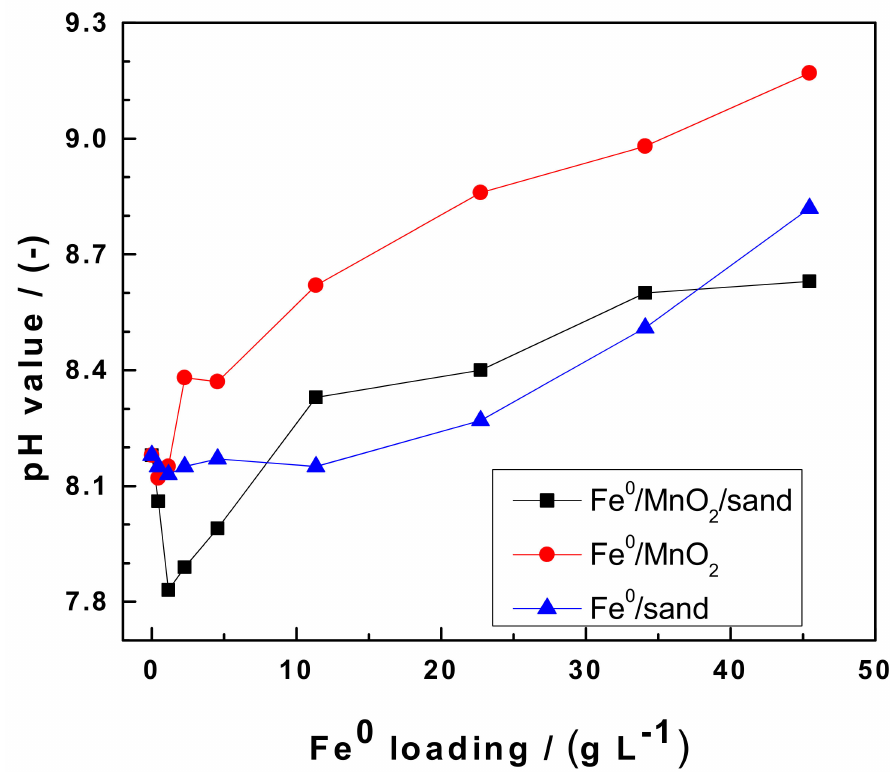
Figure 3. pH value in Fe 0 /sand/MnO 2 systems as impacted by the addition of various Fe 0 loading for 7 days. Experimental conditions: [Fe 0 ] = 2.3 to 45 g L − 1; [sand] = 45 g L − 1; and [MnO 2 ] = 2.3 g L − 1, shaken intensity: 75 rpm. The lines are not fitting functions, they simply connect points to facili- tate